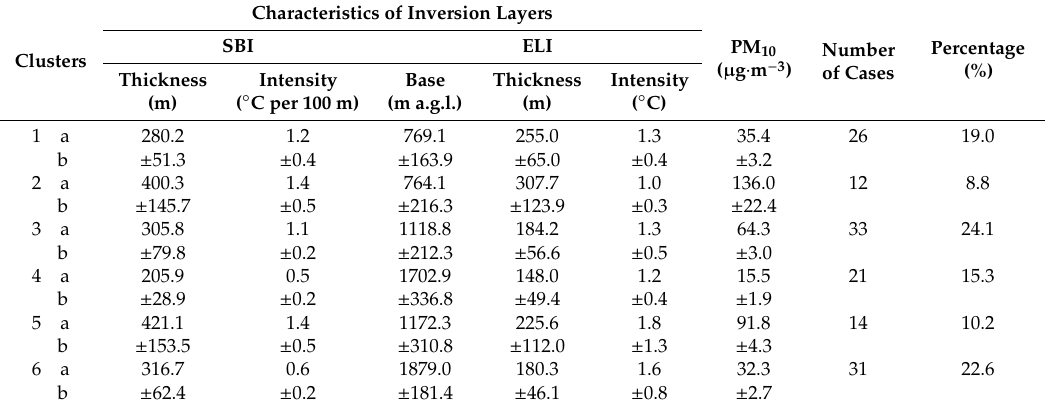
Table 1. Characteristics of inversion layers and PM 10 concentrations in distinct clusters. Characteristics of Inversion Clusters